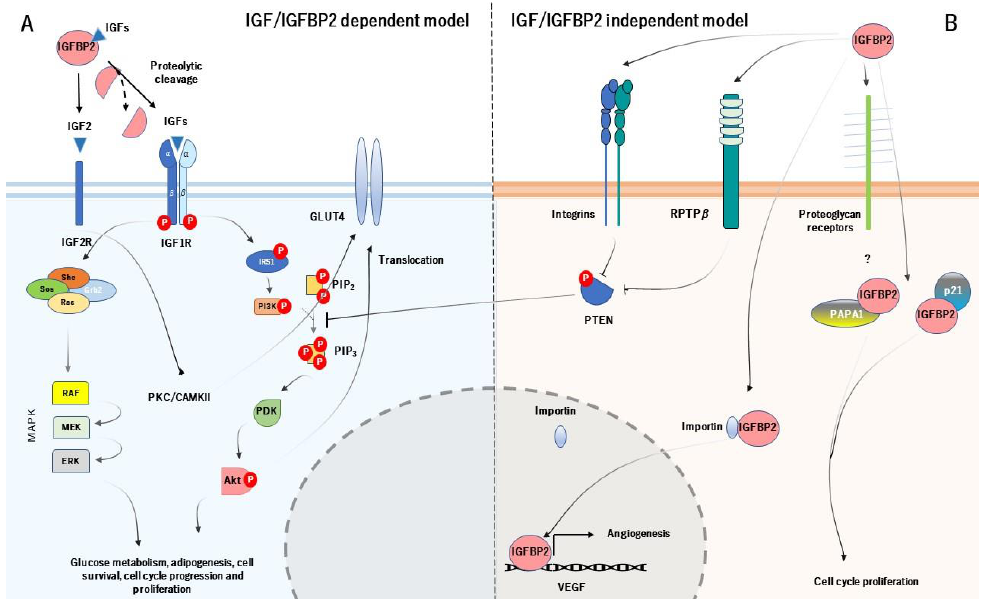
Figure 2. The cellular action of IGFBP2 is mediated by two principal models. The IGF-dependent model ( A ) modulates the activity and bioavailability of IGFs, which prevents the binding of IGFs to their receptor. The IGF-independent model ( B ) constitutes the physical interaction between IGFBP2 and specific receptors at the cell surface and extracellular matrix, which acts as a ligand. The main function of both models is regulating cell cycle, insulin, and glucose metabolism and angiogenesis.